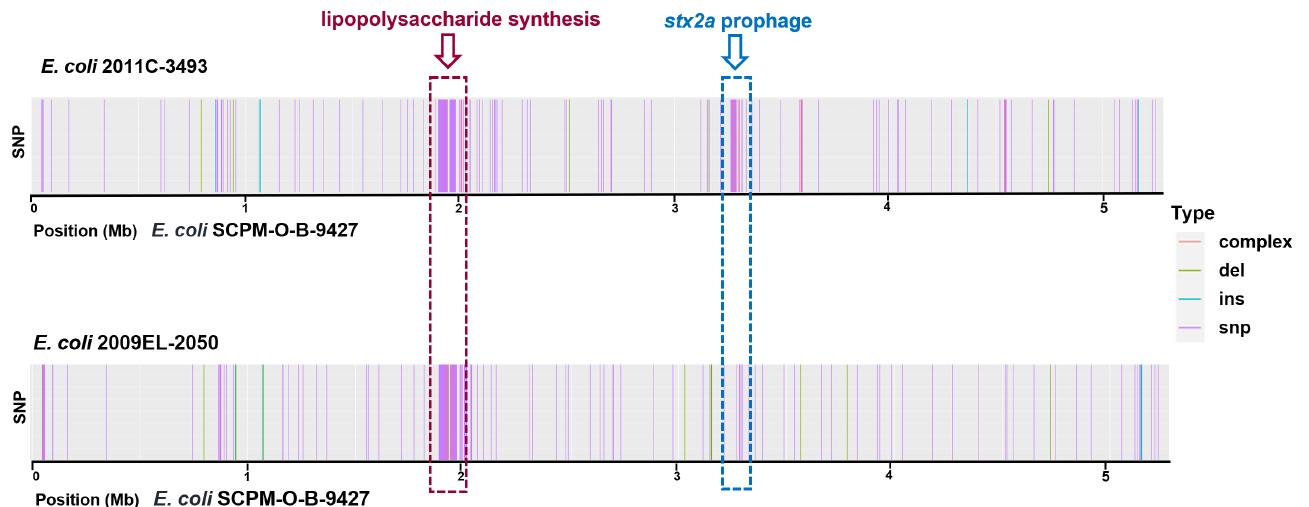
Figure 1. Distribution of the sequence variations at a genomic position. Chromosome mapping of EAHEC strains 2011C-3493 and 2009EL-2050 was performed against of the strain SCPM-O-B-9427 chromosome.